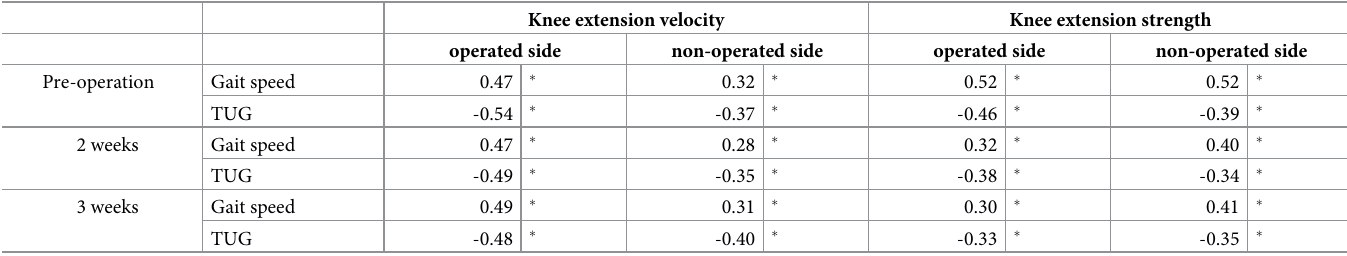
Table 3. Correlations between gait function and knee function (n =